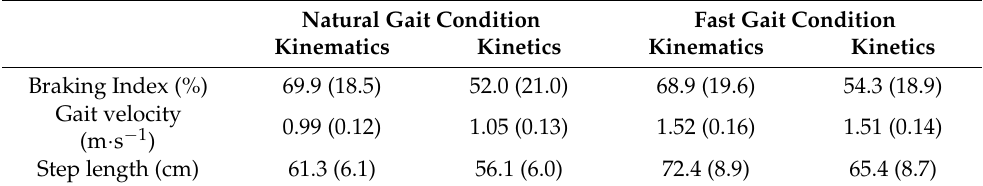
Table 1. Gait parameters during gait initiation measured with the kinematic and kinetic methods (mean